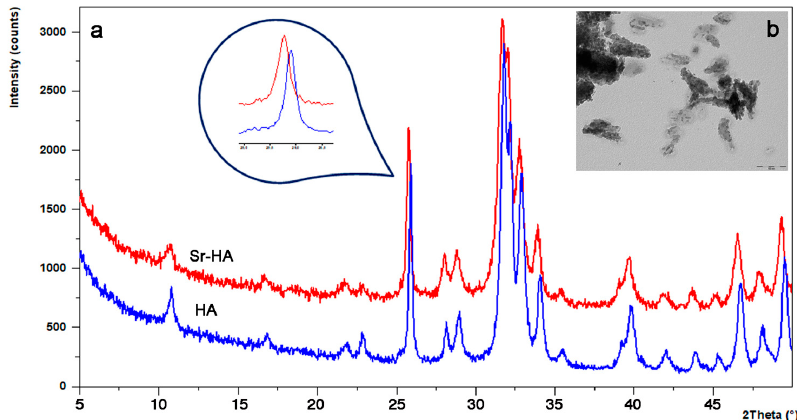
Figure 1. ( a ) X-ray diffraction pattern of Strontium-substituted hydroxyapatite (Sr-HA) and Hydroxyapatite (HA). The inset reports an enlargement of the 25–26.5 2 θ range where the shift of the 002 reflection is clearly appreciable; ( b ) TEM image of Sr-HA nanocrystals (bar = 100nm).